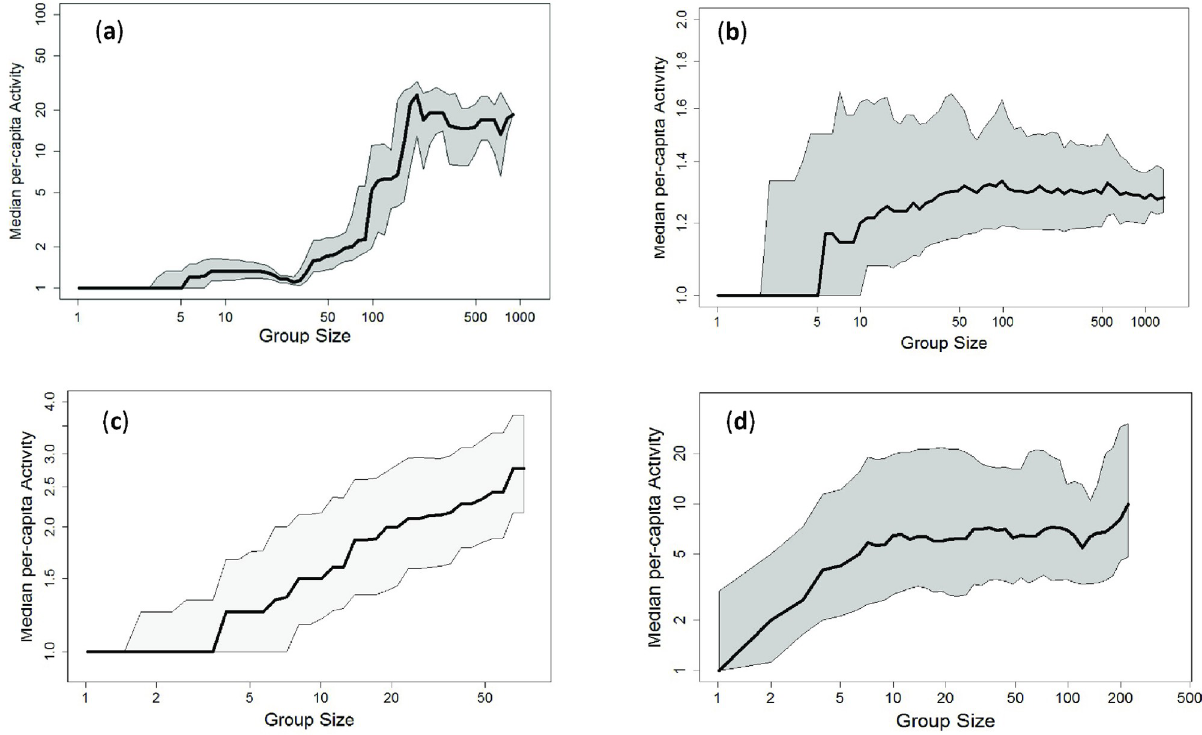
Fig 5. Activity median as a function of community size for other platforms. (a) Boards.ie (BRDS), (b) YouTube (YOUT), (c) Wikipedia (WIKI) and (d) Goodreads (GOODR). For visualizations of other platforms see Figs A and B in S1 File.